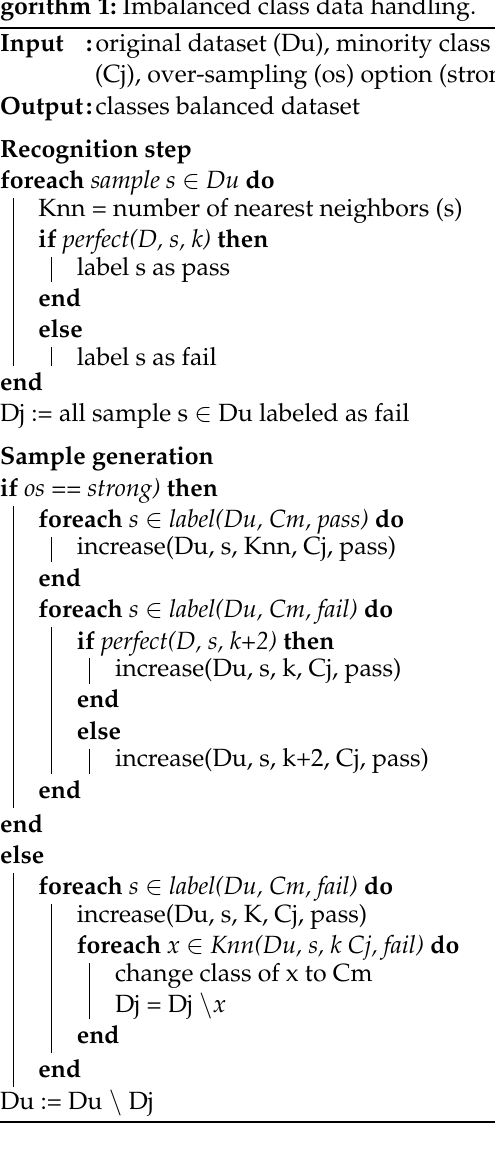
Algorithm 1: Imbalanced class data